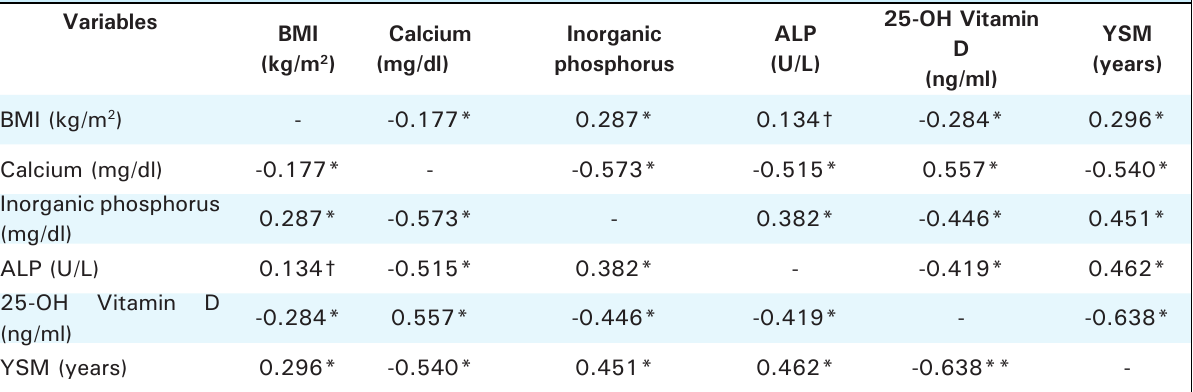
Table 3. Correlation of different variables among post-menopausal women. (n=177)